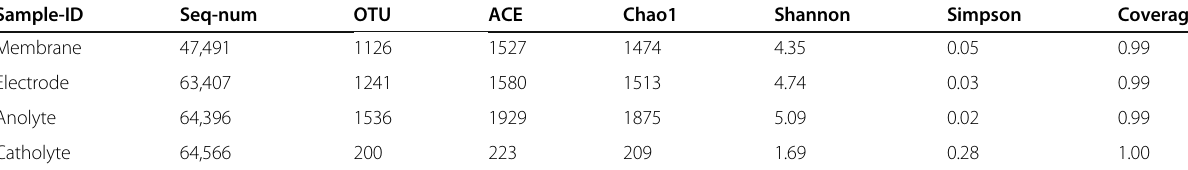
Table 3 Species diversity of microbial communities on different OsMFCs sites